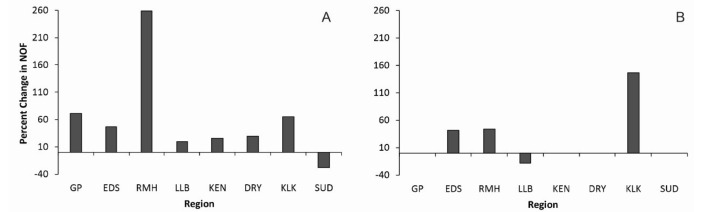
Figure 2. Percent change in total number of spring human-caused Number of Fires (NOF) based on model predicted changes from a low to high DC f ( A ) and P ow ( B ). The range of DC f used for Alberta was 100 to 500 and Ontario 25 to 350. For P ow the range for Alberta was 25 mm to 200 mm and Ontario 150 mm to 450